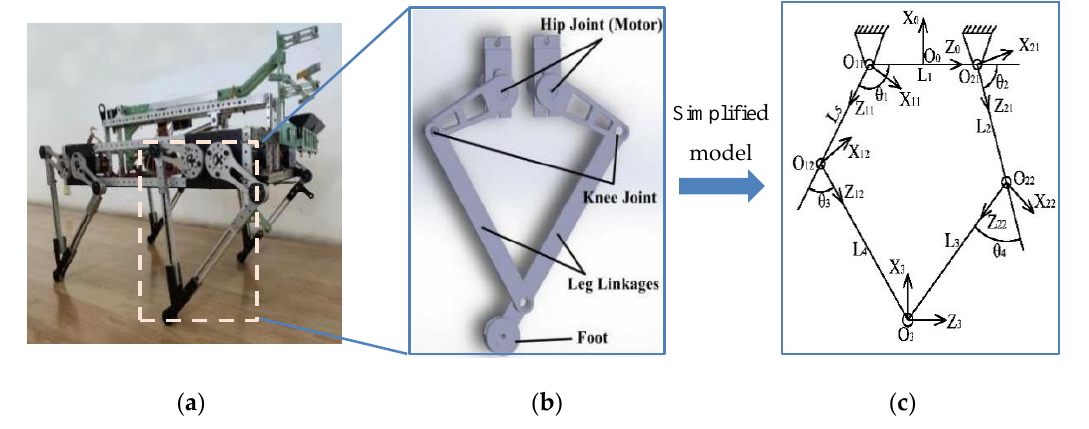
Figure 1. Model building of quadruped robot, ( a ) mechanism schematic of quadruped robot, ( b ) model of quadruped robot with single leg, ( c ) single-leg kinematics model of quadruped robot.